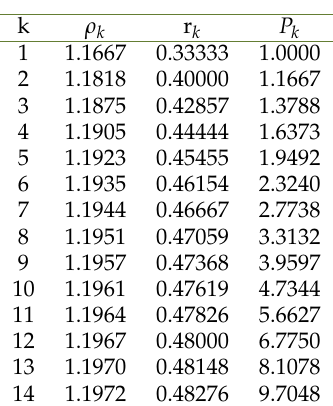
Table 2. Computation of ρ k ,r k and P